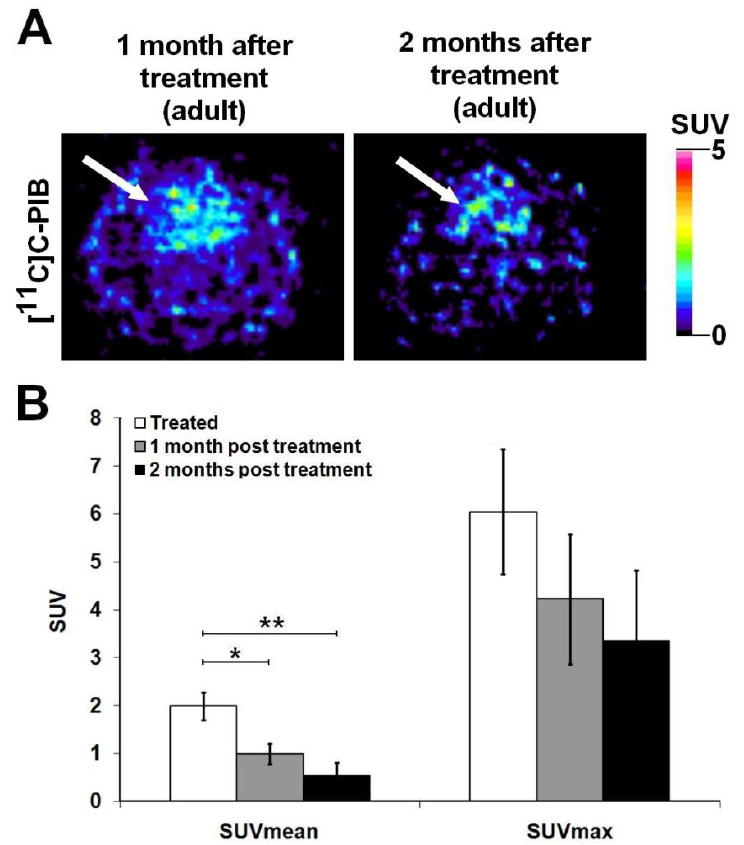
Figure 4. In vivo assessment of cerebral [ 11 C]C-PIB accumulation one and two months after the restoration to normal diet and tap water. ( A ) Represents the transaxial PET slices of the rats previously receiving combined (cholesterol rich and Al 2 (SO 4 ) 3 ) diet one ( A left ) and two ( A right ) months after the restoration to normal rodent chow and tap water. ( B ) Presents the results of quantitative SUV analyses. One and two months after the reintroduction of normal diet, the cerebral [ 11 C]C-PIB accumulation of AD-mimicking hypercholesterinaemic animals, decreased by half and third; respectively to the value measured after the administration of a month-long combined (Al 2 (SO 4 ) 3 and cholesterol) treatment. SUV values are presented as mean ± SD. Significance levels p ≤ 0.05 (*) and p ≤ 0.01 (**). PET: Positron Emission Tomography; [ 11 C]C-PIB: [ 11 C]C Pittsburgh compound B; SUV: standardised uptake value; SD: standard deviation. White arrow: brain.